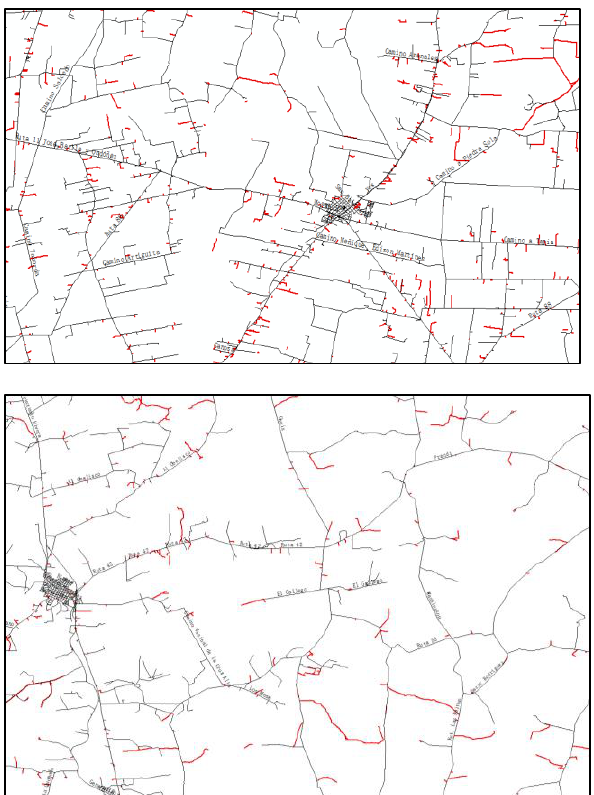
Figure 5. Fusion test results in South